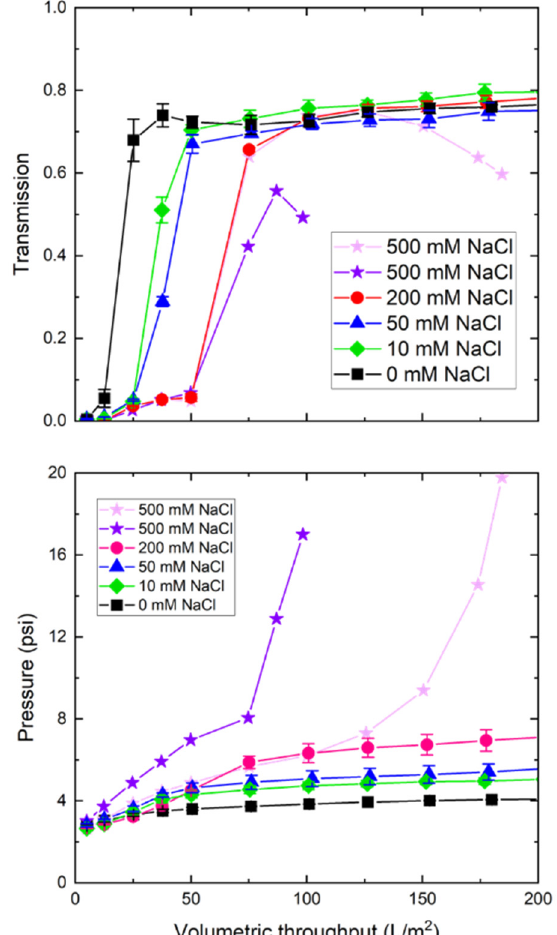
Figure 4. Nanoparticle transmission ( top panel ) and transmembrane pressure ( bottom panel ) during filtration of the 30 nm blue polystyrene nanoparticles through 0.1 µm mixed cellulose ester membranes in the presence of added NaCl at a constant filtrate flux of 150 LMH.